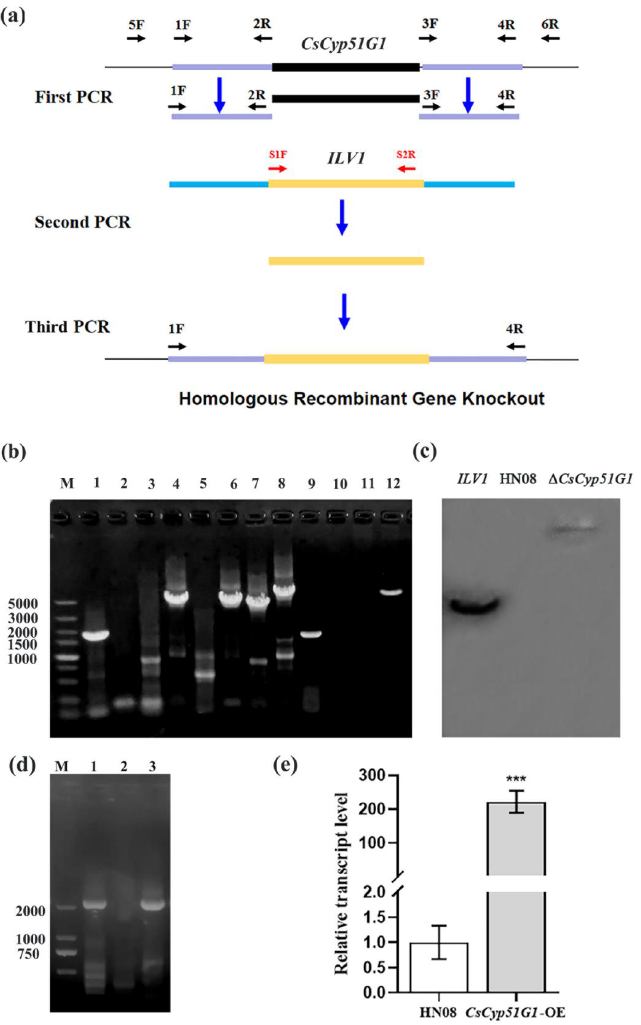
Figure 1. Verification of the gene deletion mutant ∆ CsCyp51G1 and overexpression strain CsCyp51G1-OE . ( a ) Schematic diagram of CsCyp51G1 gene deletion and primers used to verify the gene replacement event. ( b ) Confirmation of the ∆ CsCyp51G1 mutant and CsCyp51G1-OE strain by PCR amplification. M: DNA DL 5000 marker; A 1712 bp fragment of the CsCyp51G1 gene coding sequence was amplified by the primer pair CsCyp51G1 -OF/OR in both HN08 (lane 1) and CsCyp51G1-OE (lane 9) but not ∆ CsCyp51G1 (lane 5). A 4217-bp fragment containing the upstream sequence of the CsCyp51G1 gene and a partial ILV1 gene sequence was amplified by the primer pair 5F/S2R from ∆ CsCyp51G1 (lane 6) but not HN08 (lane 2) or CsCyp51G1-OE (lane 10). A 4018-bp fragment containing the downstream sequence of the CsCyp51G1 gene and a partial ILV1 gene sequence was amplified by the primer pair S1F/6R from ∆ CsCyp51G1 (lane 7) but not HN08 (lane 3) or CsCyp51G1-OE (lane 11). A 5267-bp fragment from ∆ CsCyp51G1 (lane 8) and a 4313-bp fragment from HN08 (lane 4) and CsCyp51G1-OE (lane 12) were amplified by the primer pair 5F/6R, which confirmed that the 1712-bp fragment of the CsCyp51G1 gene was replaced by the 2817-bp fragment of the ILV1 gene. ( c ) Southern blot analysis of total genomic DNA samples from WT and ∆ CsCyp51G1 were digested with Eco RI. The probe was an ILV1 PCR fragment amplified from the sulfonylurea resistance cassette of the plasmid pCX62-S. ( d ) PCR with the primer pair RP27F/CsCyp51G1-OR amplified a 2189-bp fragment from the plasmid pXY203-RP27-Cyp51G1 and the CsCyp51G1-OE overexpression strain but not the wild-type strain. ( e ) Relative expression of CsCyp51G1 determined by qRT-PCR in CsCyp51G1-OE strains and WT HN08. Expression levels were normalized using ACT expression levels as controls. Data were collected from three technical replicates. Error bars represent the standard deviations, *** indicated significant differences at p < 0.001 (Student’s paired two-tailed t